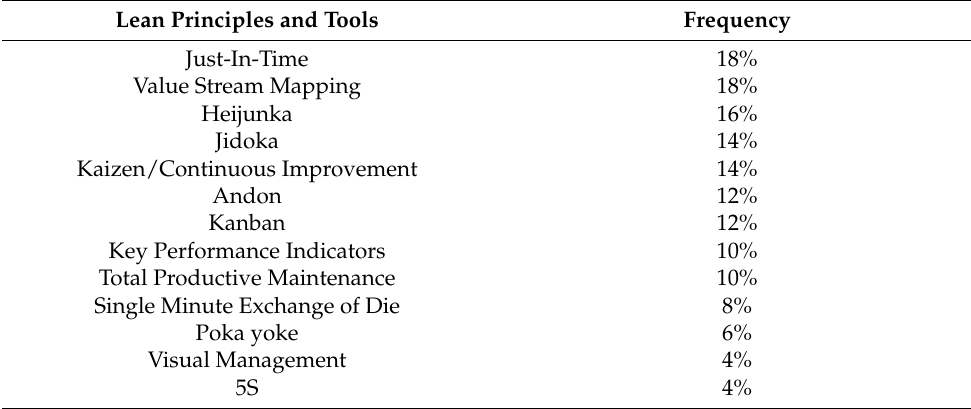
Table 5. Most relevant Lean techniques and/or